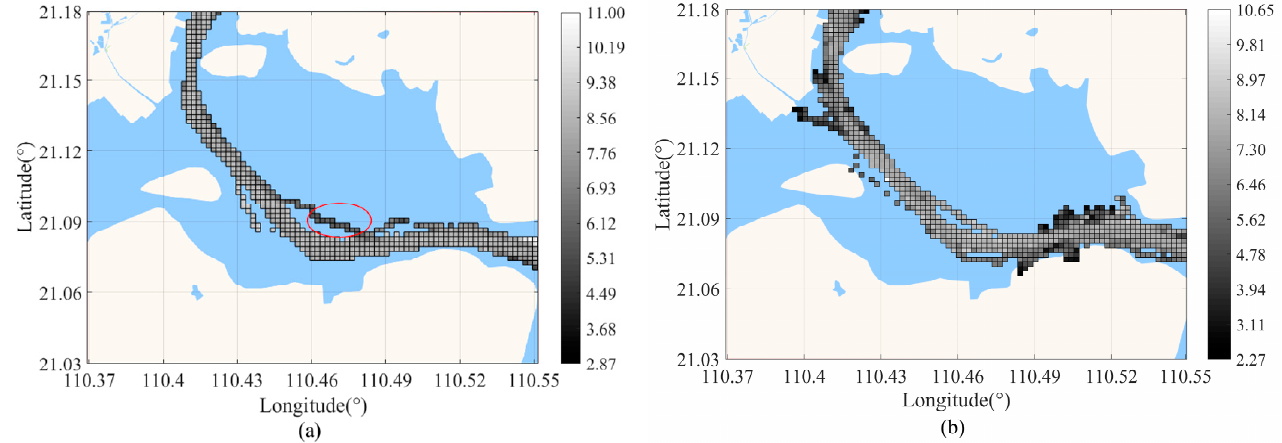
Figure 18. Speed spatial distribution of outgoing and incoming ships. ( a ) Speed spatial distribution of outgoing ships; ( b ) speed spatial distribution of incoming ships.